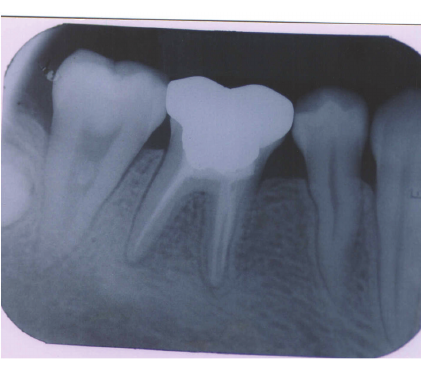
Figure 5: Crown placed (36).